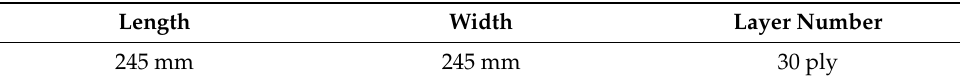
Figure 4. ( a ) Press-molding machine; ( b ) Press-molding die attached to heating plate.